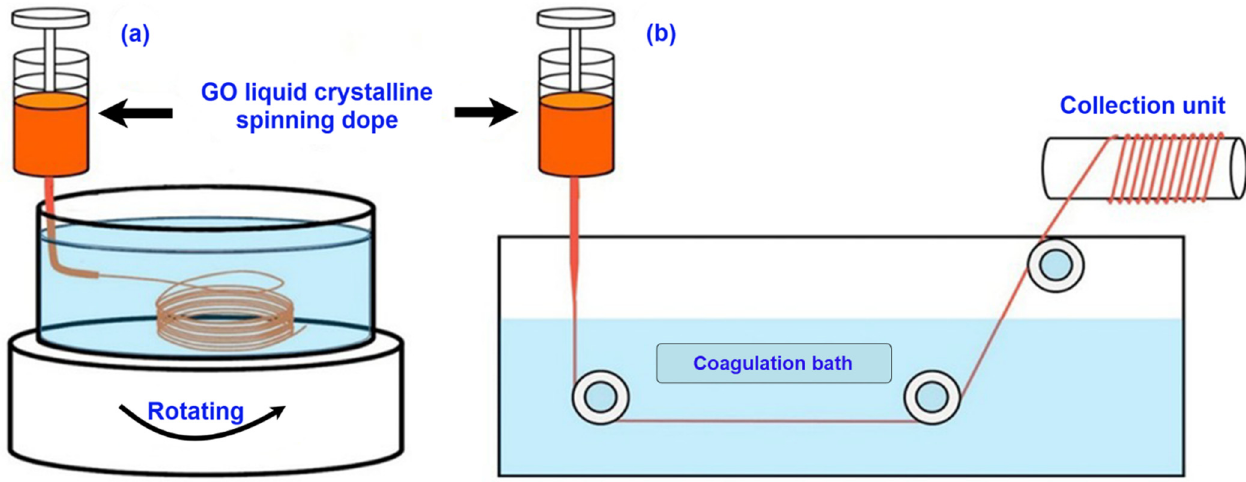
Figure 3. ( a ) Wet-spinning process of GO fibres, ( b ) collection process after the coagulation process; Reprinted with permission from [67].